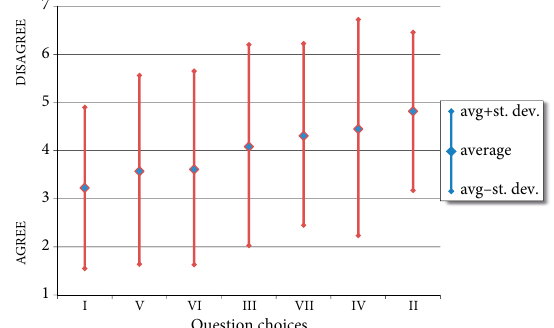
Fig. 4. Opinions about the functions of marketing department